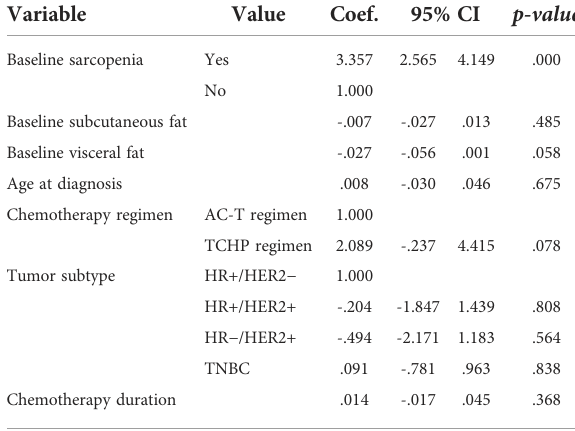
TABLE 3 Sarcopenia prevalence during neoadjuvant chemotherapy. Group